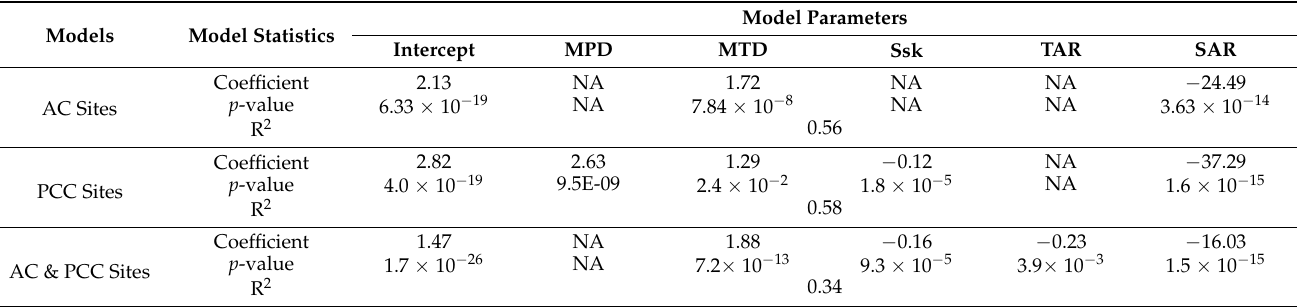
Table 4. Results of DFT prediction models via